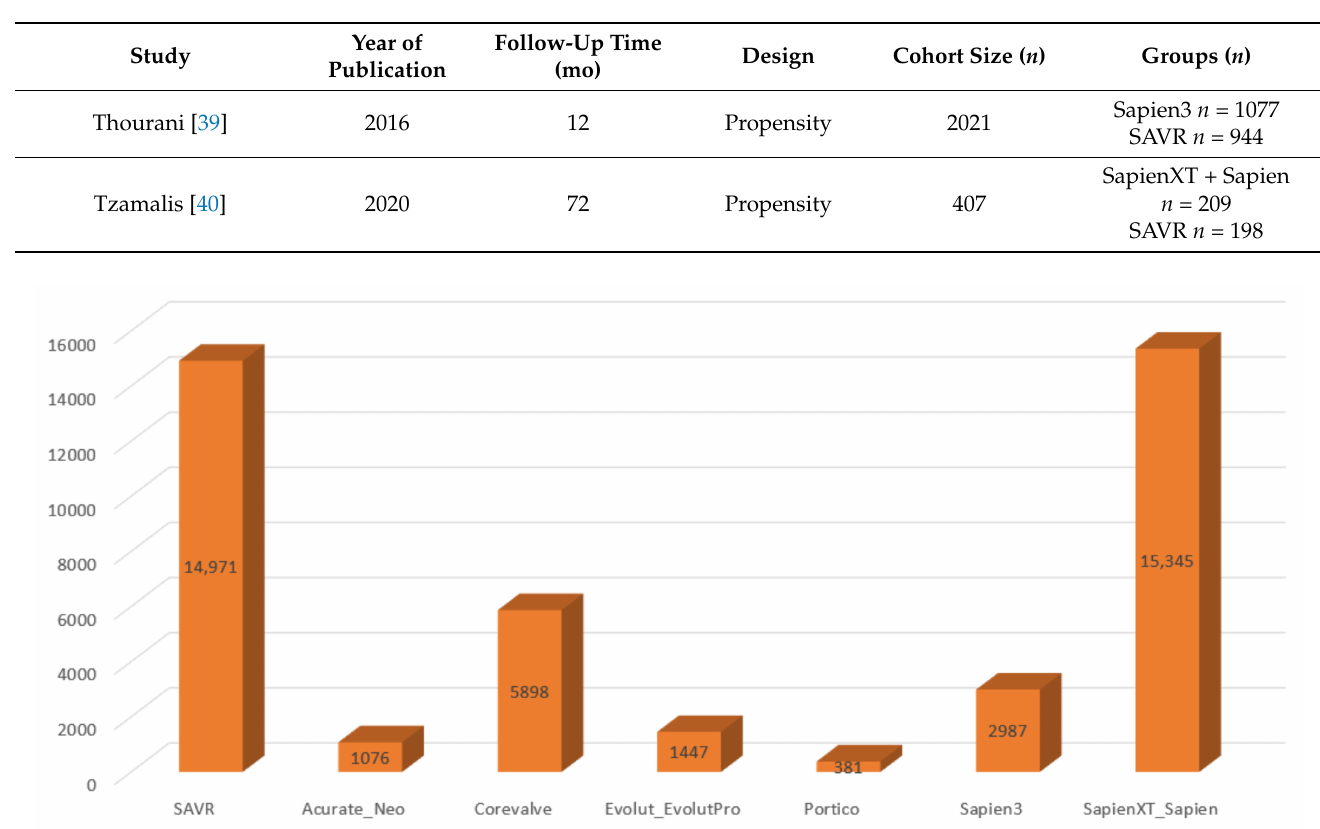
Representativeness of SAVR and various TAVI valves in the included